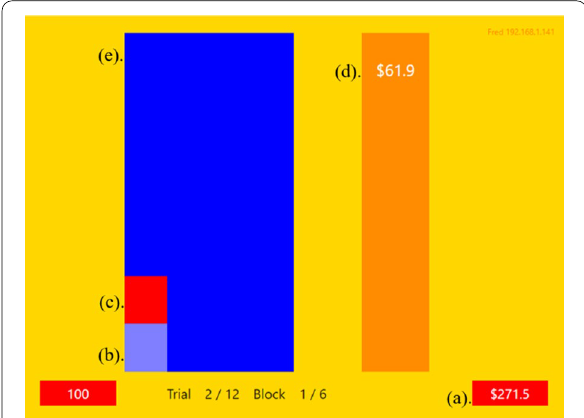
Fig. 2 Example of the feedback provided to participants at the completion of each block. Participants were randomly assigned pseudonyms for the duration of the